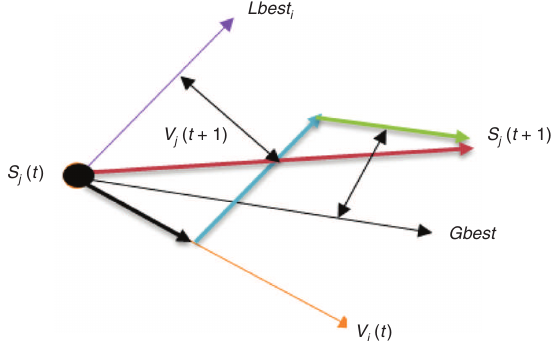
Figure 1: Particle Swarm